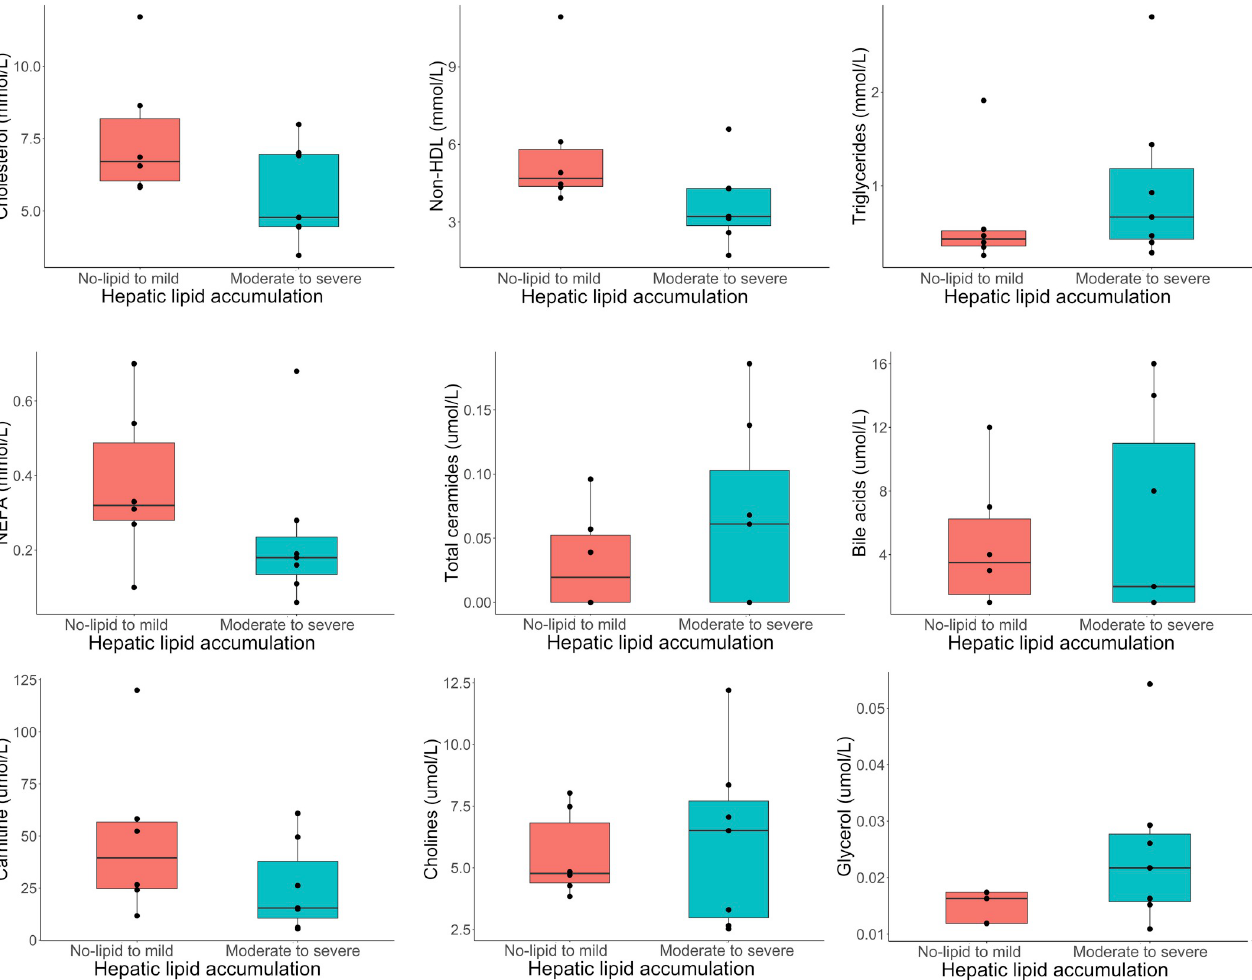
Fig 8. Side-by-side box plots with superimposed dot plots of selected plasma variables (cholesterol [mmol/L], non-HDL [mol/L], NEFA [mmol/L], total ceramides [umol/L], carnitine [umol/L], and cholines [umol/l]) across two simplified classes of hepatic lipid changes (no-lipid to mild and moderate to severe) in bearded dragons based on an established grading system [30] evaluated by serial t-tests. These variables were not statistically significant after correcting for false discovery, but interesting trends can be